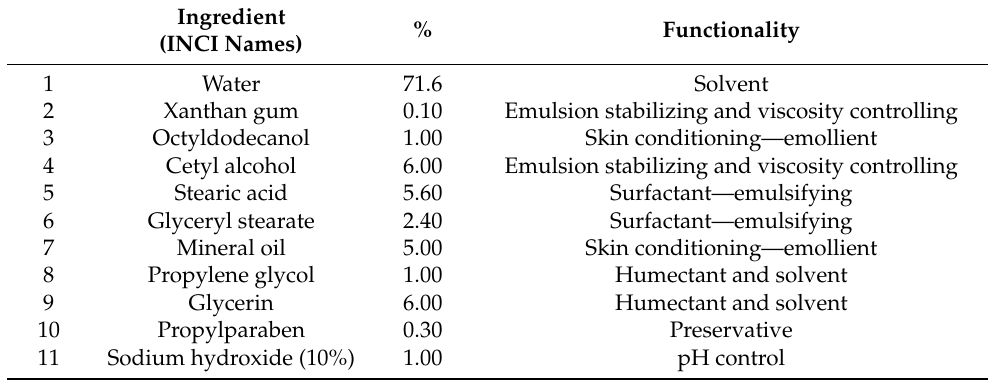
Table 1. Composition of exfoliant formula base to evaluate the Passiflora ground